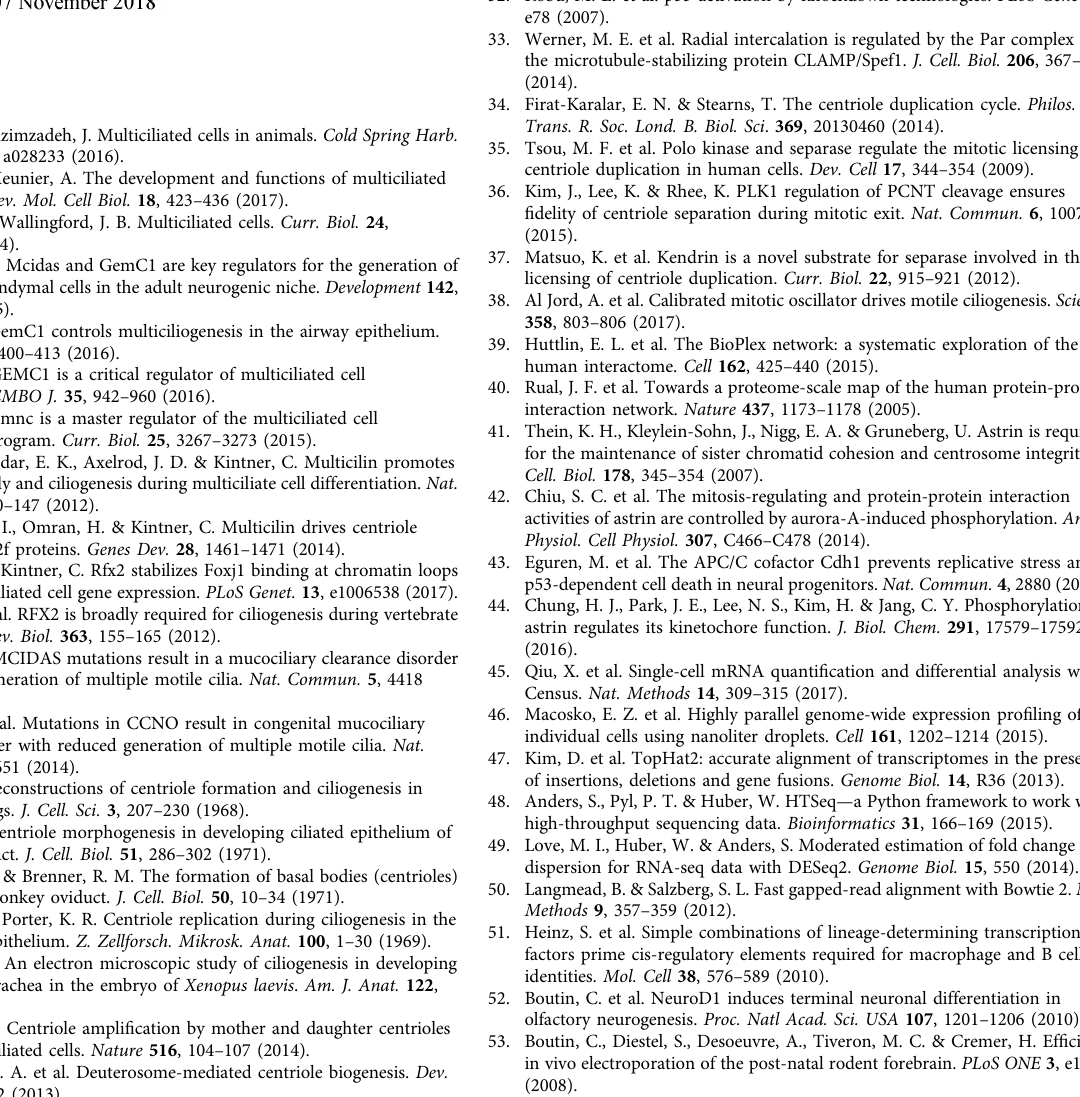
Figure 7g: 5 fi elds (×20 zoom) per condition were analyzed, and the total number of properly ciliated MCCs based on acetylated α -tubulin staining among GFP positive cells per fi eld was counted. Each fi eld corresponded to a different embryo. Figure 5s: 160 – 200 cells per condition were analyzed. n = 6, 8, and 10 embryos from three independent experiments for control, Mo ATG and Mo Spl, respectively. Unpaired t test vs control: p = 0.0037 (Mo ATG **) and 0.0004 (Mo Spl ***). Data